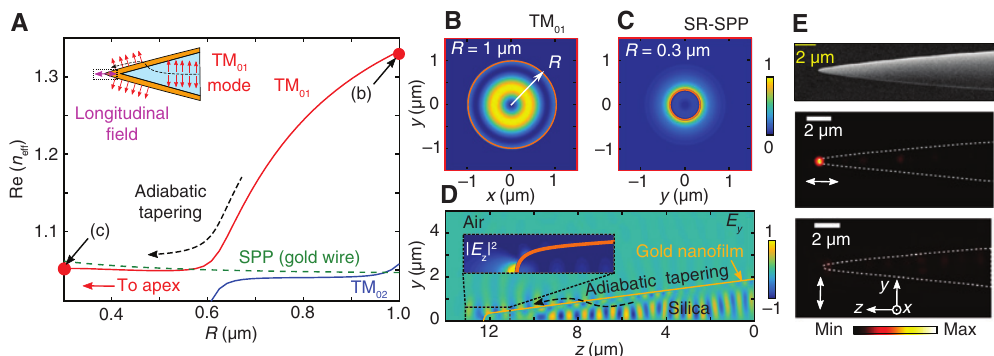
Figure 5: Superfocusing of SPPs on a metal-coated optical fiber tip. (A) Real part of the effective index for the relevant modes supported in a typical experimental configuration [61]. The red curve represents the RP dielectric (internal) mode (intensity distribution at R = 1 μ m shown in B) of the fiber that anticrosses with the (external) RP plasmonic mode (shown in C at R = 0.3 μ m; dashed green line), enabling plasmonic adiabatic tapering. (D) 3D finite element simulation illustrating the evolution of the intensity (| E | 2 ) of the mode that incidence from the right into the fiber tip. Inset: field enhancement at the plasmonic tip z due to the axially polarized mode. (E) Example of a gold-coated fiber tip (gold thickness: 30 nm, plasmonic tip radius: 100 nm) excited by an RP mode ( λ = 780 nm). Top: SEM image of the fiber structure. Also shown are polarization resolved optical microscope images of the light emitted from the tip. Middle/bottom: horizontally/vertical oriented polarizer between tip and camera (adapted from Ref. [61]). Reprinted with permission from Ref. [61]. Copyright 2015 American Chemical